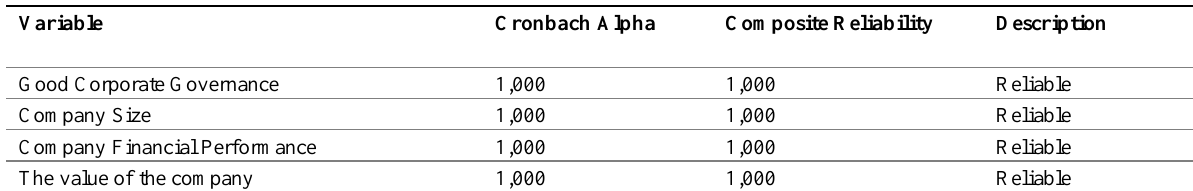
Table 5: Reliability Test Results